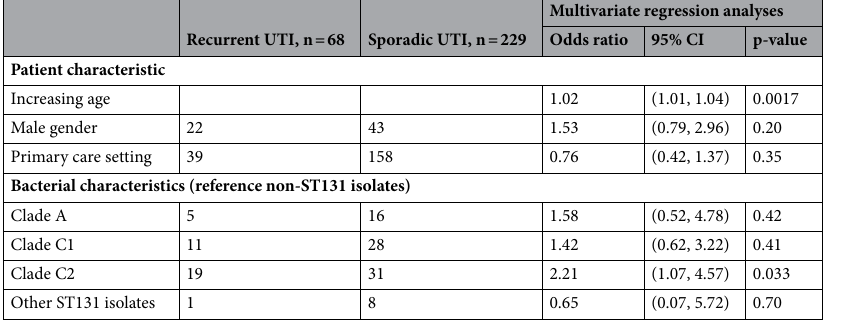
Table 5. Multivariate regression analyses of the association of recurrent urinary tract infections with patient characteristics and selected sequence type (ST)131 characteristics in 297 patients with ESBL- E. coli urinary tract infection